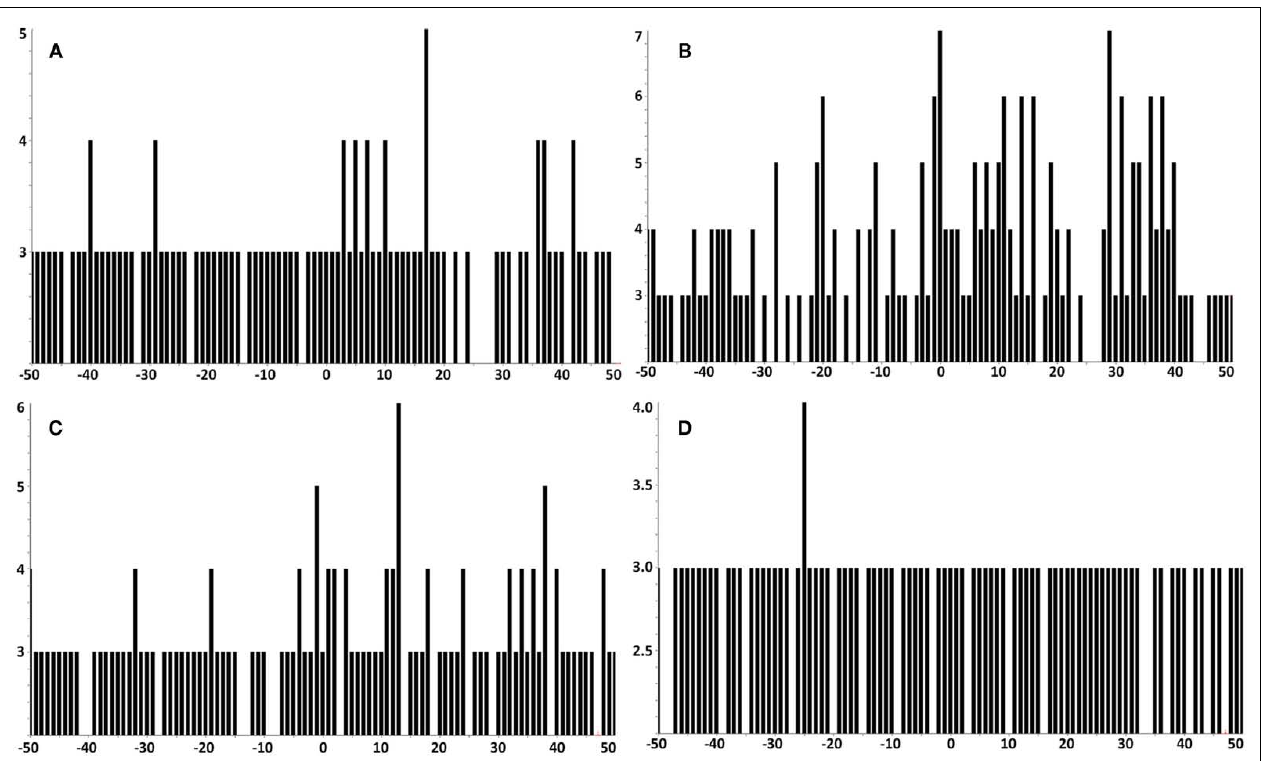
FIGUREA7 | In all tumor samples where E7 11–20 was checked, it was not detected. MS 3 Poisson detection plots for E7 11–20 are negative for both the E7 11–19 positive samples KTS1, KTS2, and KTS4 (A–C) and the E7 11–19 negative sample KTS8 (D) .